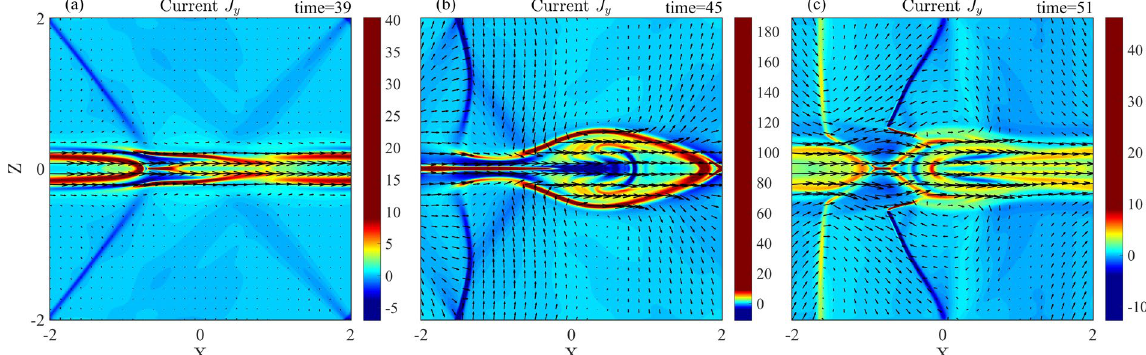
Figure 6. Color contours of the current density (J y ) with magnetic field lines (black solid lines) and flow vectors (black arrow) for the streaming flow v 0 = 2.0 at ( a ) t = 39, ( b ) t = 45, and ( c ) t = 51, corresponding to a, b, c labeled in Fig. 5, respectively.